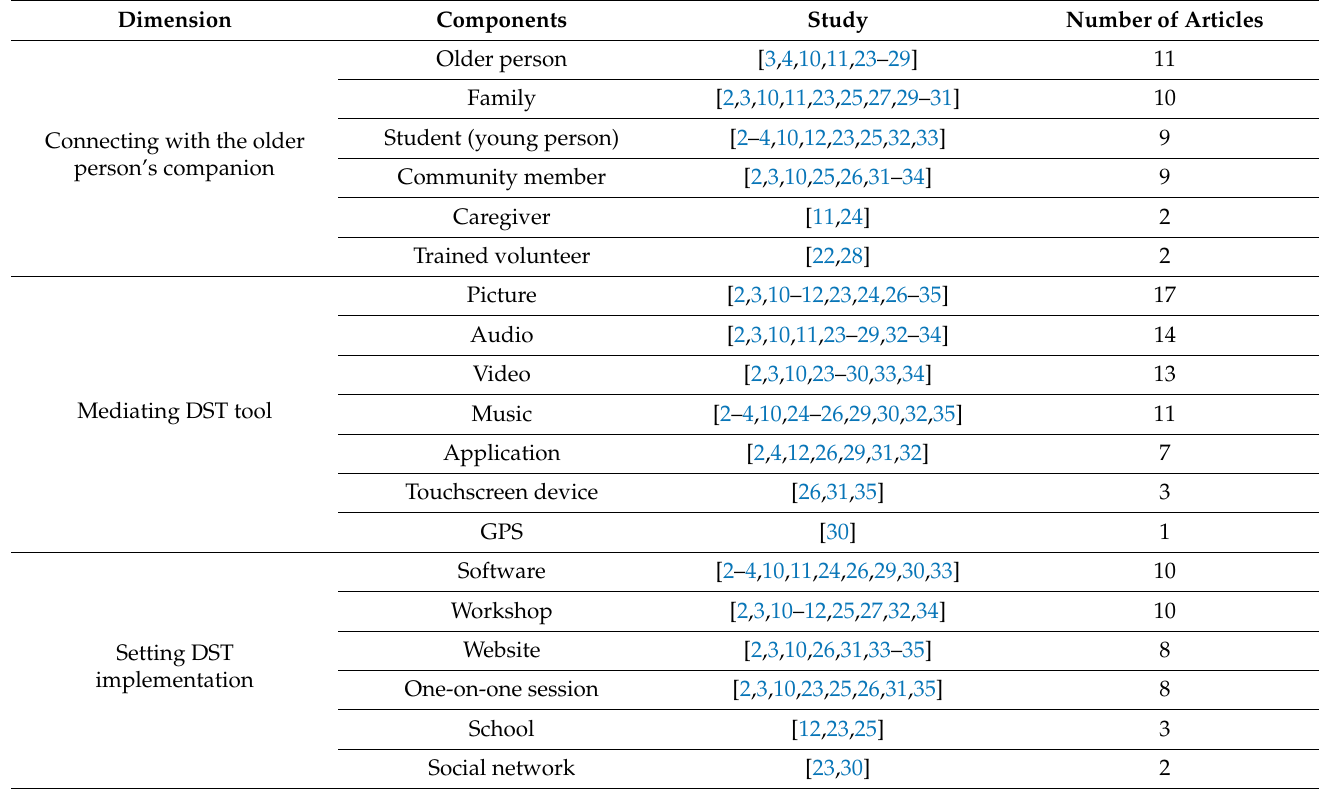
Table 2. Application structure for digital storytelling